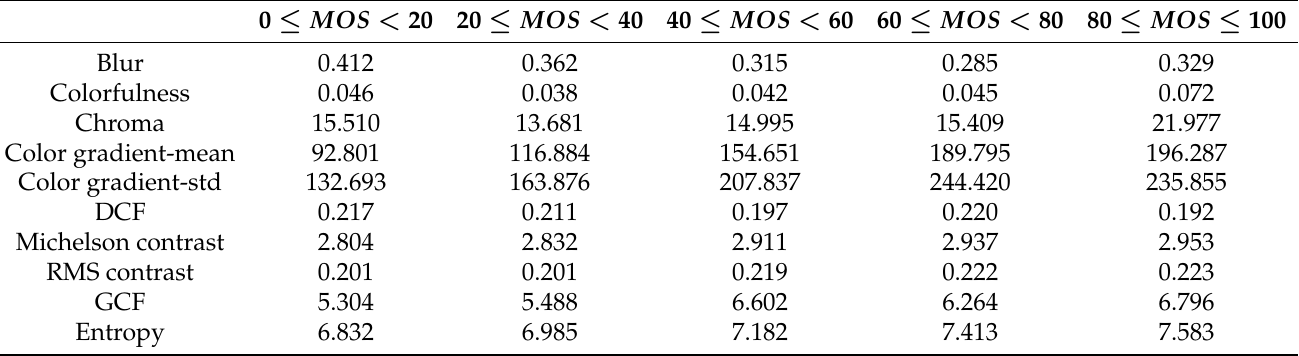
Table 4. Mean values of perceptual features in CLIVE [45] with respect to five equal MOS